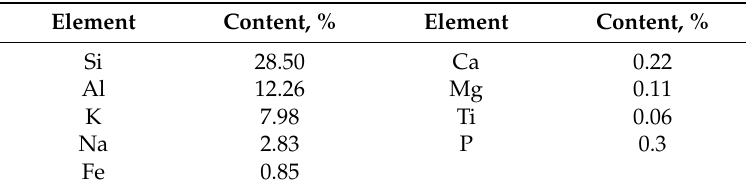
Table 1. Chemical analysis results of the sample.